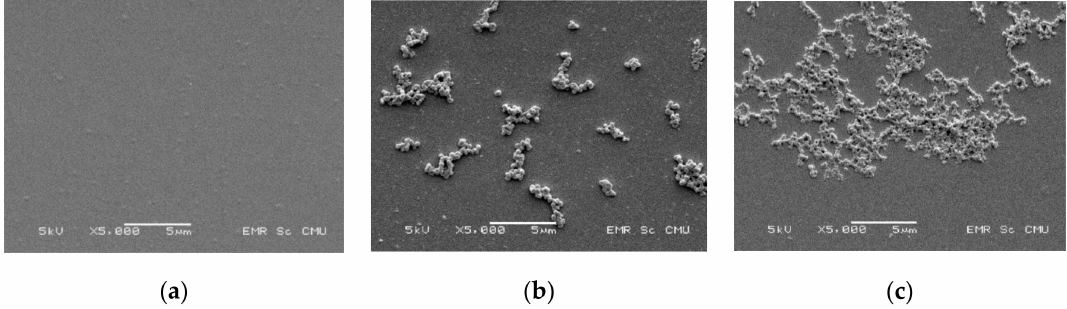
Figure 5. SEM images of ( a ) Si surface ( b ) with APTES layer and ( c ) with APTES-GA layer.